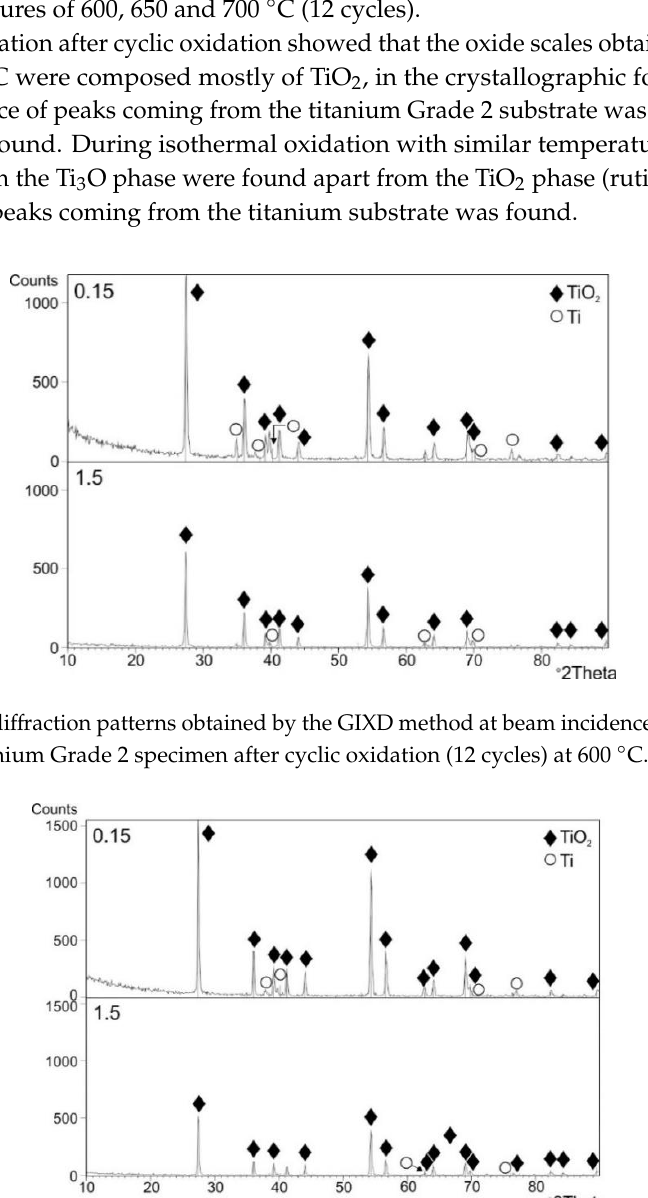
Figure 11. A set of diffraction patterns obtained by the GIXD method at beam incidence angles α = 0.15° and 1.5°, for a titanium Grade 2 specimen after cyclic oxidation (12 cycles) at 700 °C.